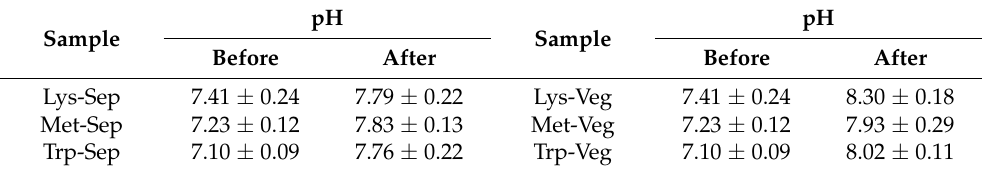
Table 2. pH measures of amino acid solutions before and after the adsorption